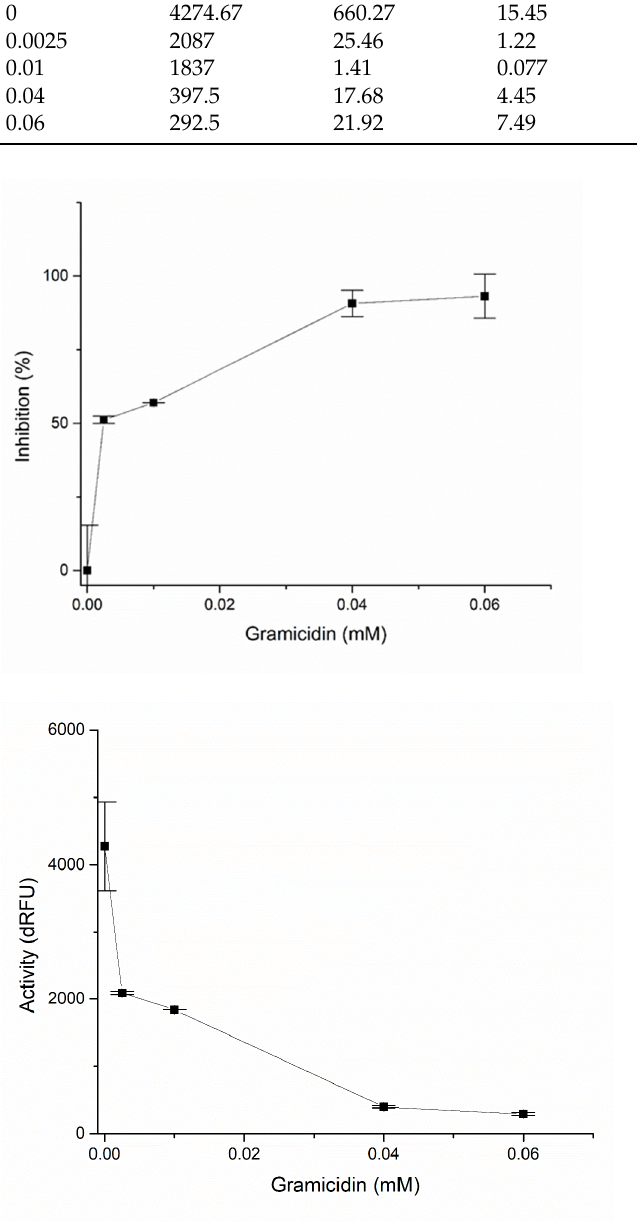
Figure 4. Inhibition (%) and activity (%) of PL pro with different concentrations of gramicidin D.